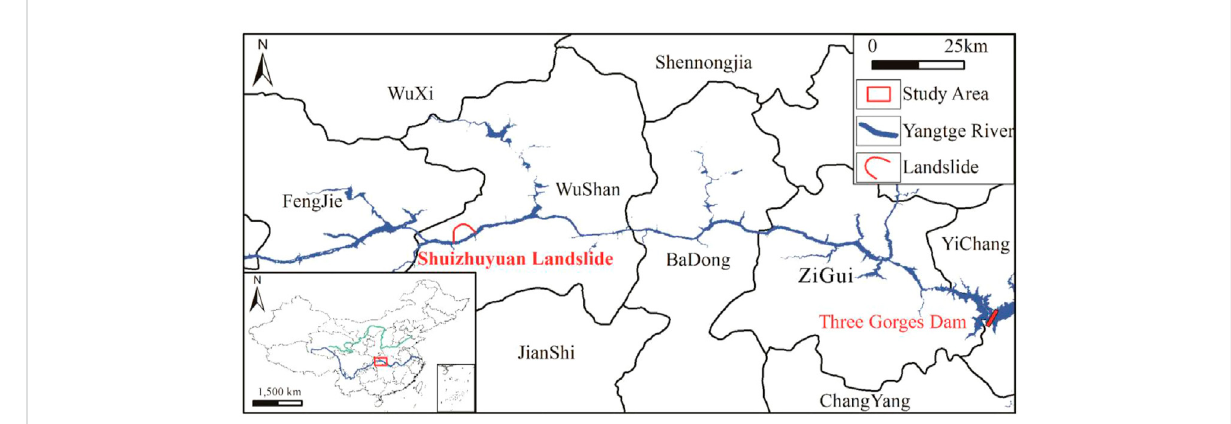
FIGURE 2 Location of the Shuizhuyuan landslide.